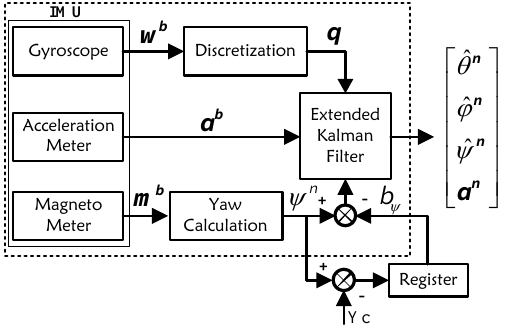
Figure 3. Flow Chart of Attitude Estimation